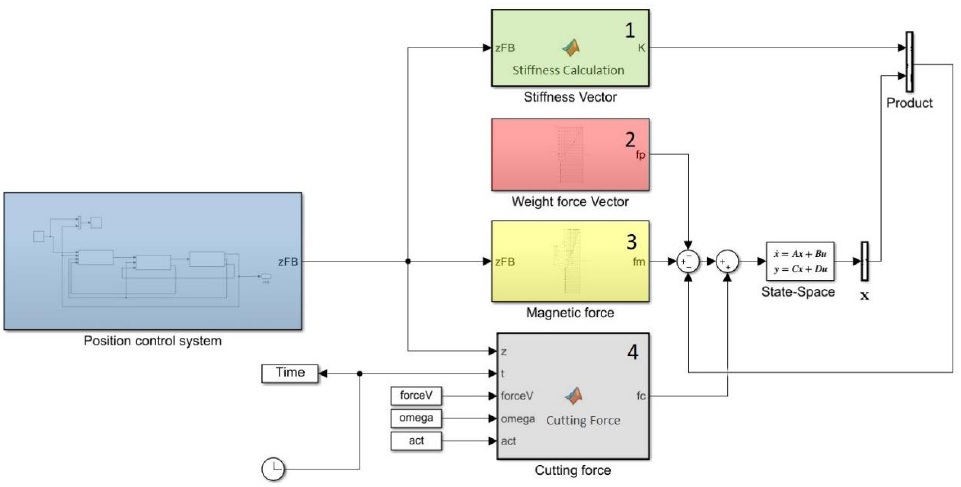
Figure 9. Simulink model of the system.